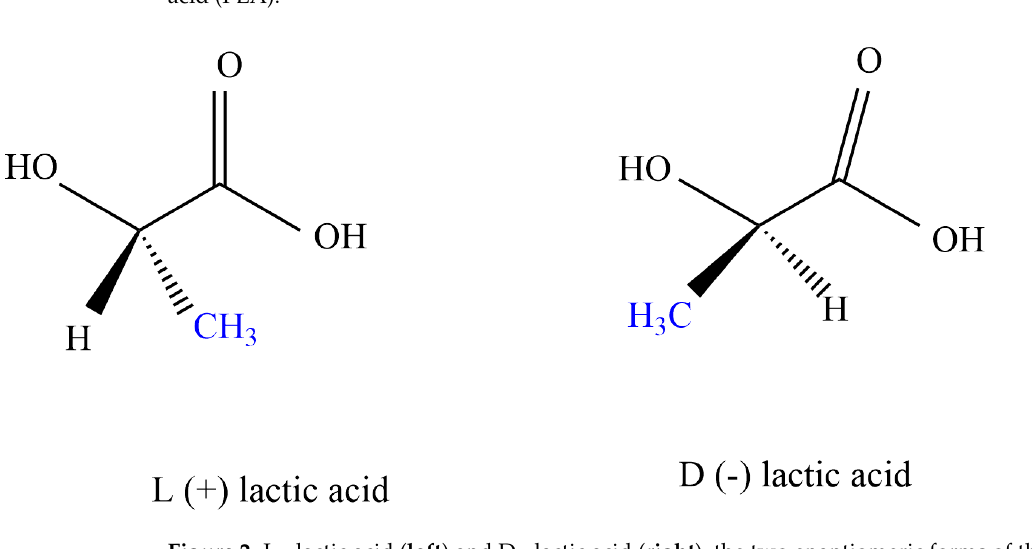
Figure 1. Lactic acid: derived from fermentation of starch, the monomer of the polymer polylactic acid (PLA).